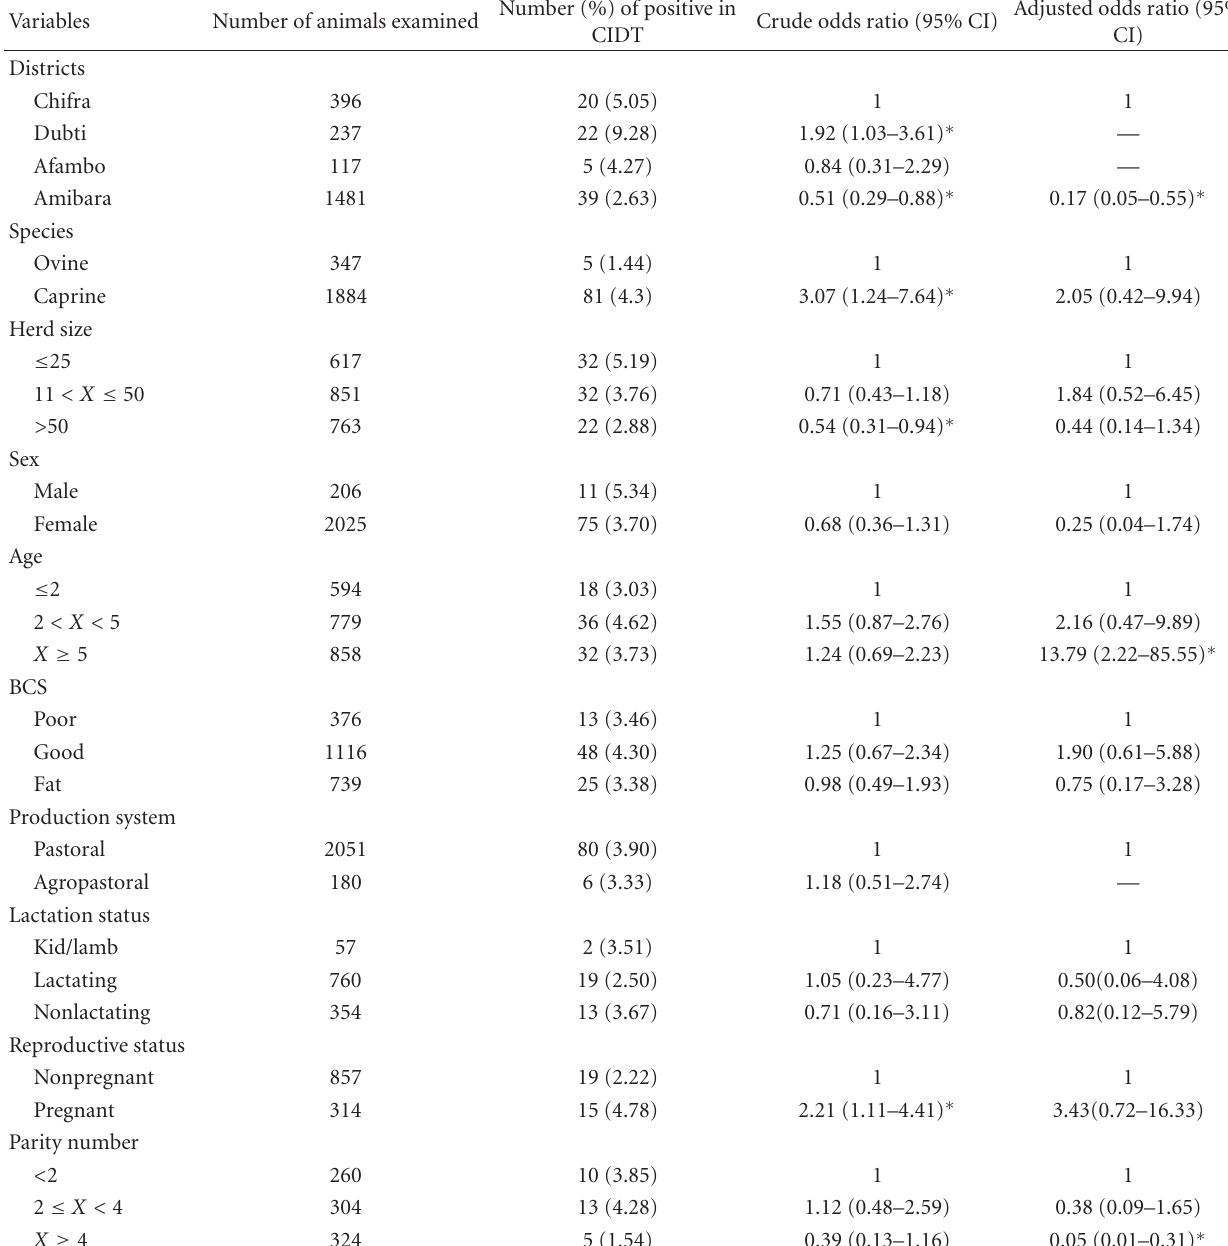
Table 2: Multivariable logistic regression analysis of tuberculin reactors with various host-related risk factors at ≥ 2mm cut-o ff point.